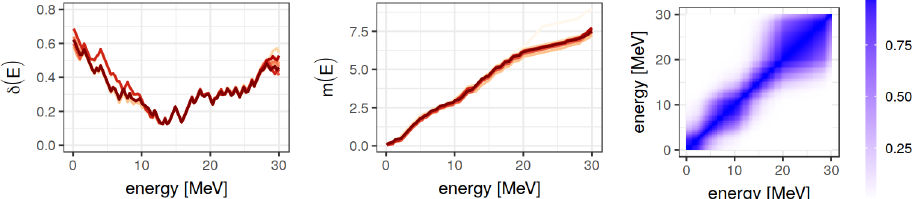
Figure 2. The dynamic time warping GP specification resulting from the marginal likelihood maximiza- tion: (left) the amplitude function δ ( . ); (middle) the metric function m ( . ); and (right) the corresponding model defect correlation matrix. Di ff erent curves in the left and middle figure correspond to di ff erent local maxima of the marginal likelihood. The majority of the ten optimization results coincide and in- dicate the global maximum. Due to the transformation of the cross sections described in the paragraph below eq. (12), the function δ ( E ) can be interpreted as relative model defect expected a